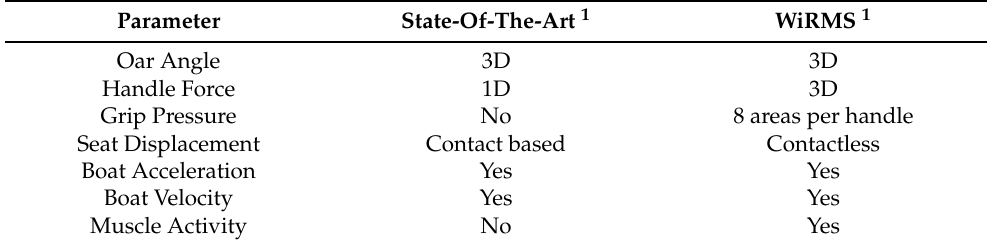
Table 1. Comparison of different system parameters between the state-of-the-art and WiRMS.